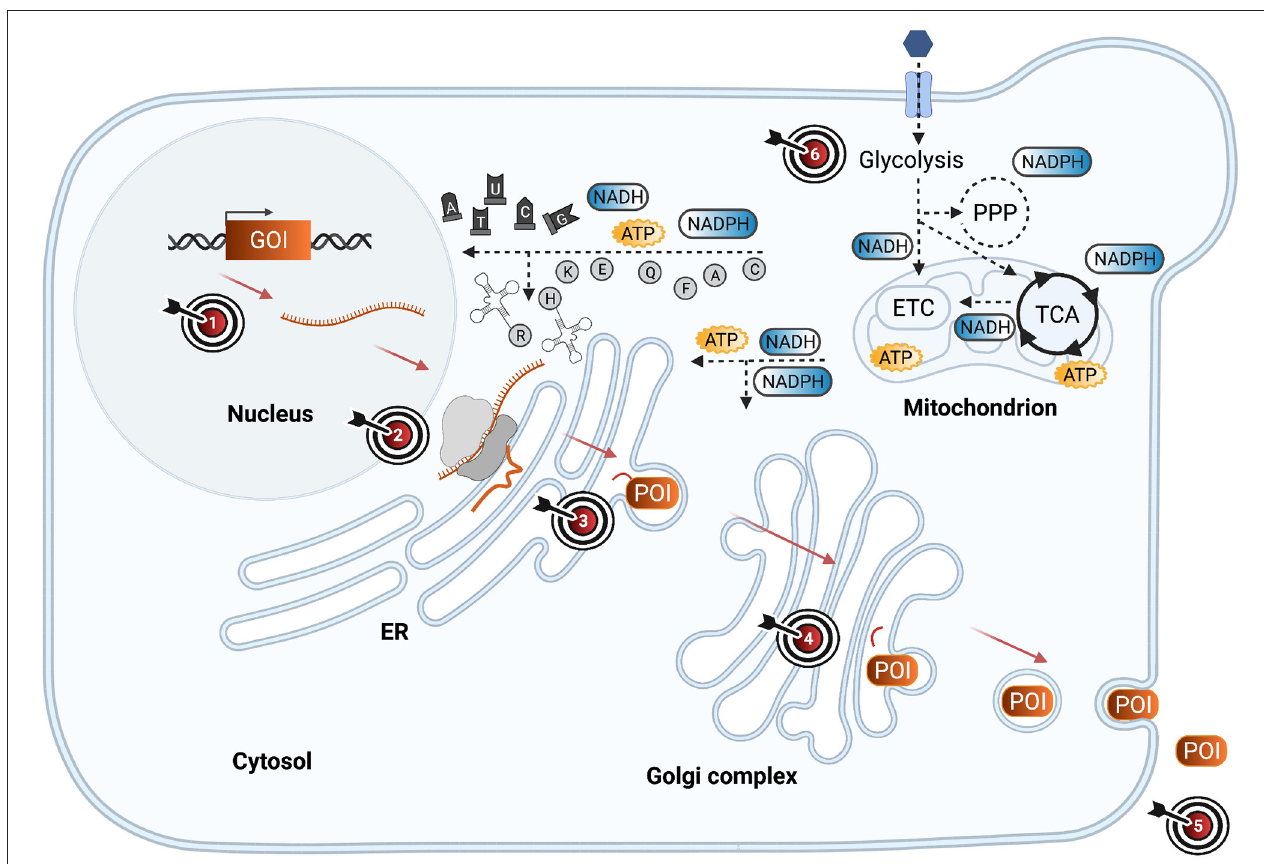
FIGURE 1 | Burden-triggering bottlenecks in yeast cell factories during heterologous protein synthesis and secretion. Schematic representation of yeast cell factory engineered to synthesize and secrete a heterologous protein of interest (POI), encoded by a gene of interest (GOI). The GOI is transcribed into messenger RNA (mRNA), later translated by ribosomes into a peptide that is translocated into endoplasmic reticulum (ER), where it is folded and modified. Via anterograde transport, the POI reaches the golgi complex for further modifications and secretion signal cleavage. Via vesicle exocytosis, the POI is secreted to the extracellular medium. Meanwhile, heterologous protein production is fueled by metabolic pathways such as glycolysis, pentose phosphate pathway (PPP), the tricarboxylic acid cycle (TCA), and the electron transport chain (ETC) which deliver energy (ATP), redox cofactors (NADPH, NADH), nucleotides, and amino acids required for heterologous protein production. Different engineering targets (ETs) that have been highlighted in literature to mitigate the burden that heterologous protein production imposes on the host cell are marked with a target symbol. ET1: Gene dosage, promoter strength, plasmid vs. genome integration. ET2: Codon optimization, co- or post-translational translocation. ET3: Tuning genes involved in unfolded protein response, oxidative stress response, ER-associated protein degradation pathways. ET4: Direct POI for secretion or express intracellularly. ET5: Process engineering by adding certain amino acids to the medium, changing the medium or carbon source. ET6: Redirecting metabolic fluxes by tuning relevant target genes. Synthetic circuit engineering for dynamic regulation may be simultaneously aimed at any combination of ETs 1–4 and/or